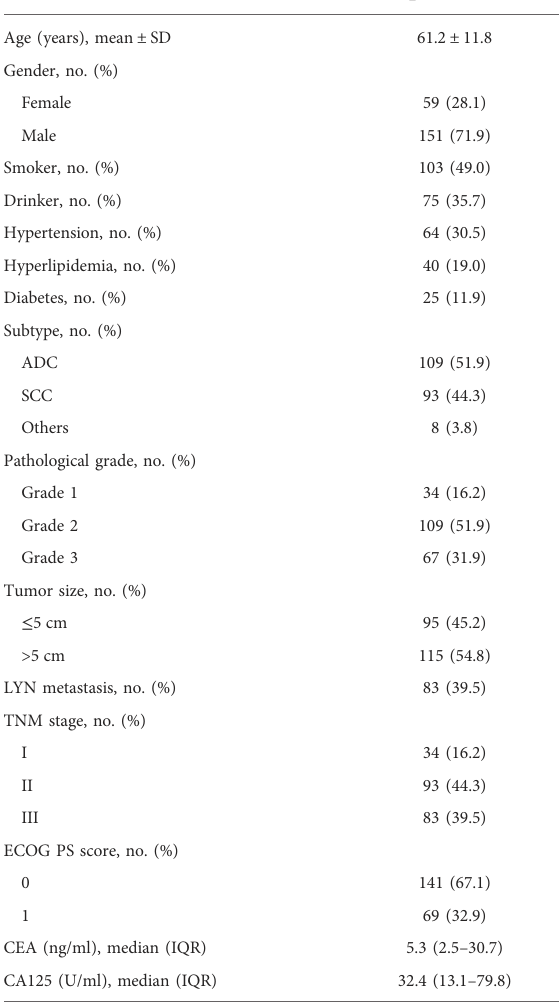
TABLE 2 Neoadjuvant and adjuvant therapy.